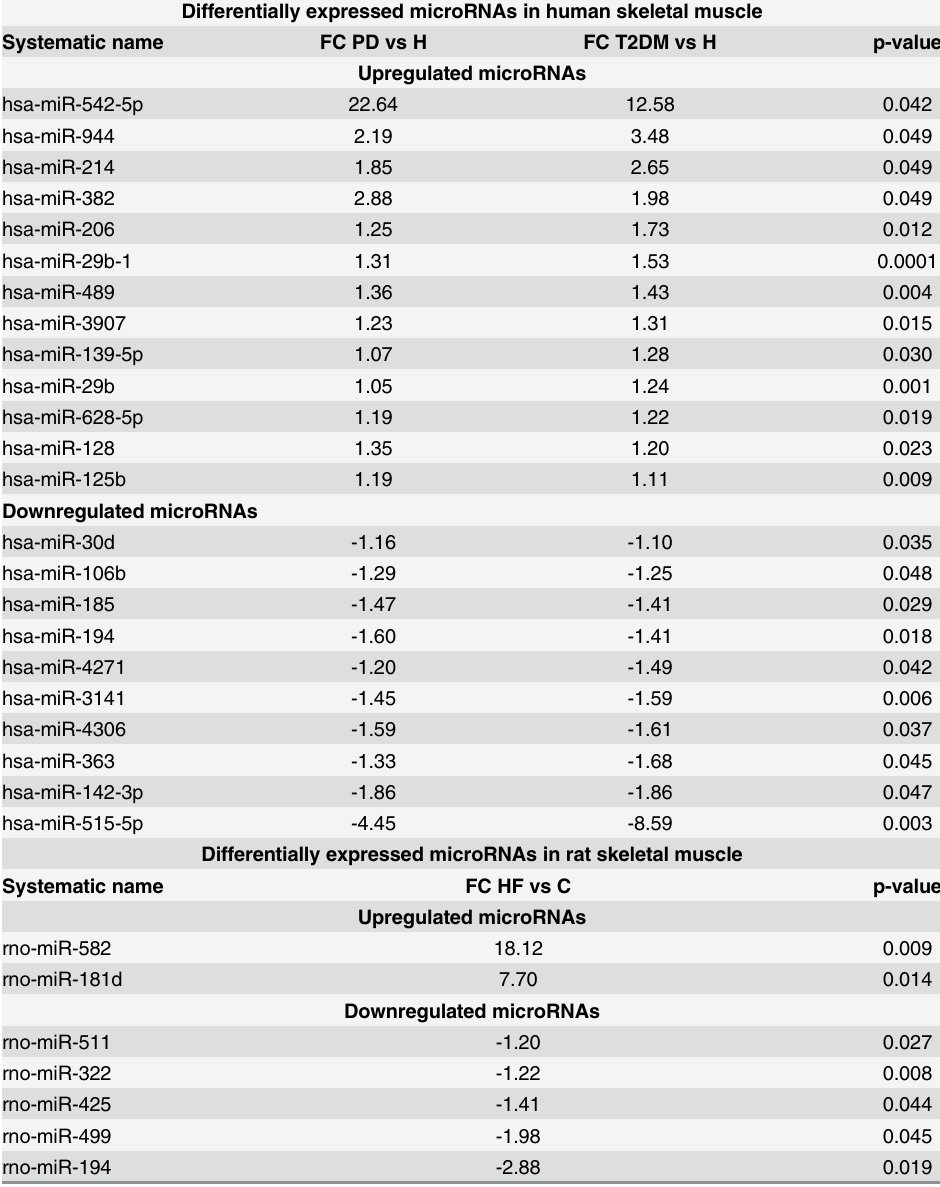
Fold-change (FC) in microRNA expression is shown in pre-diabetics (PD) or type 2 diabetics (T2DM) vs healthy participants (H) for human data, and in offspring from high fat-fed dams (HF) vs offspring from